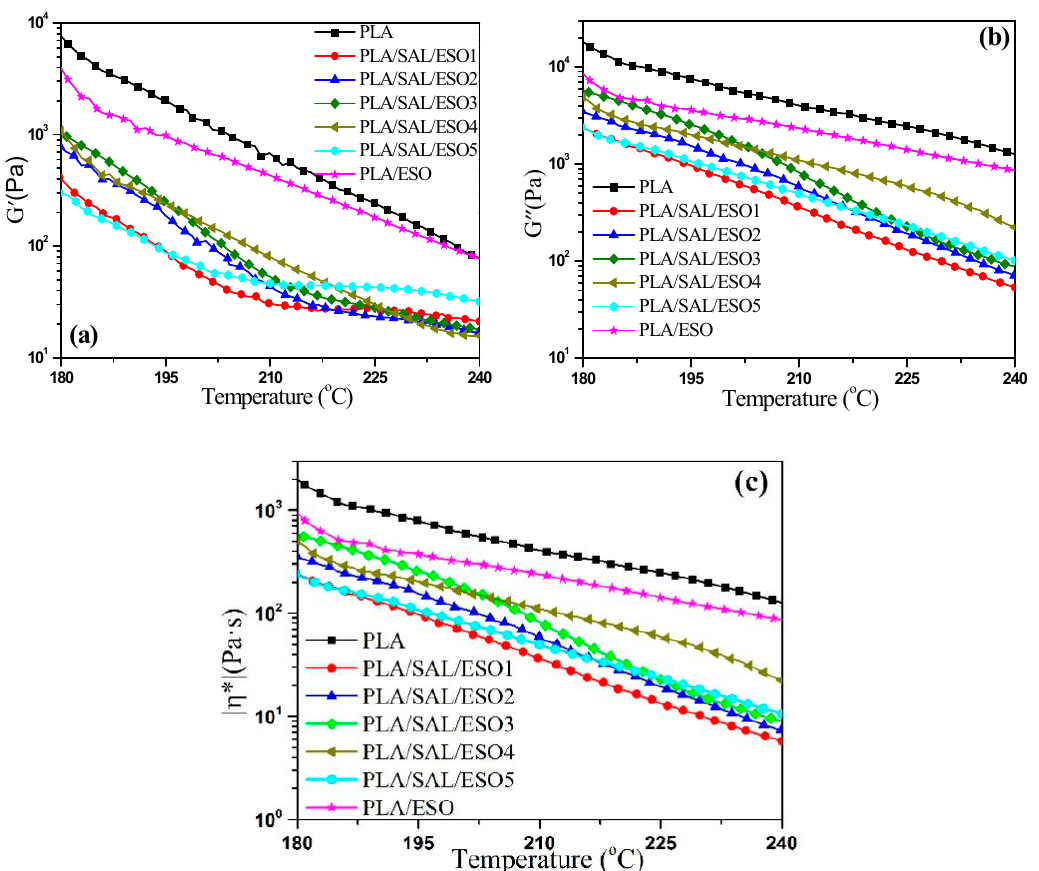
Figure 7. Temperature ramp sweep curves for pure PLA, PLA/ESO, and PLA/SAL/ESO composites: ( a ) storage modulus ( G ´), ( b ) loss modulus ( G ´´), and ( c ) complex viscosit y (| η * |).